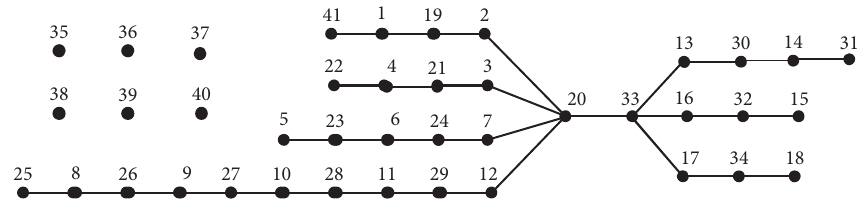
Figure 1: The (consecutively) SEM labeling of DT ( 4 , 4 , 5 , 10 ; 0 ; 4 , 3 , 3 ) ∪ 6 K